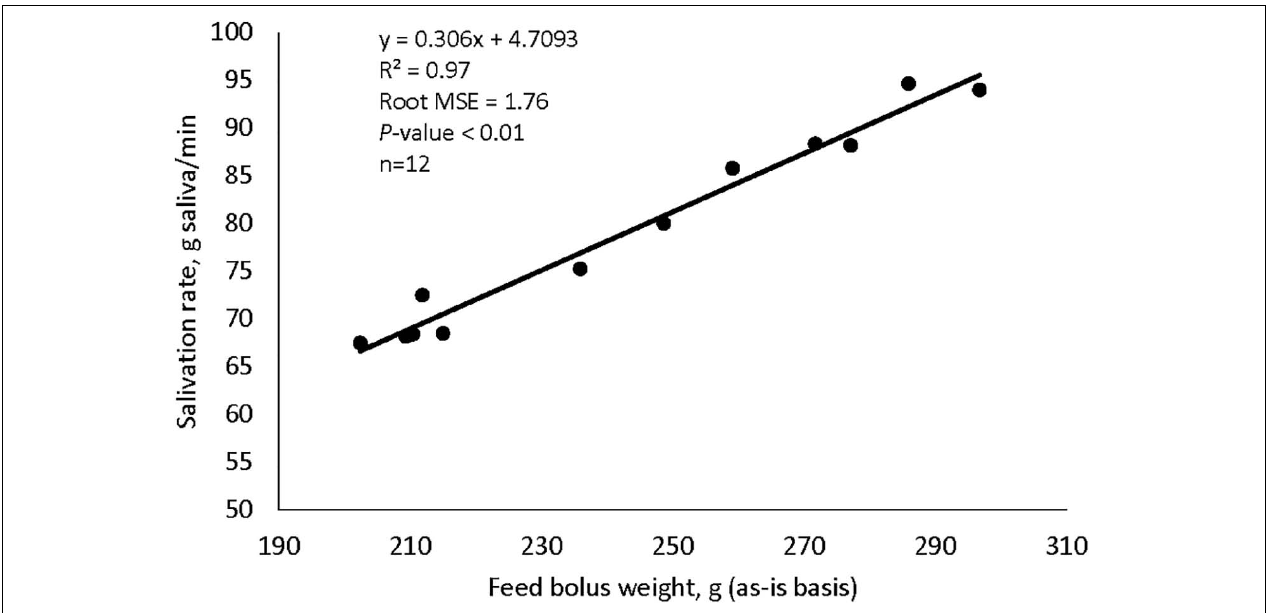
FIGURE 4 | The influence of feed bolus weight on the salivation rate in cattle fed concentrate-rich diets, plot includes values across all nine phytogenic